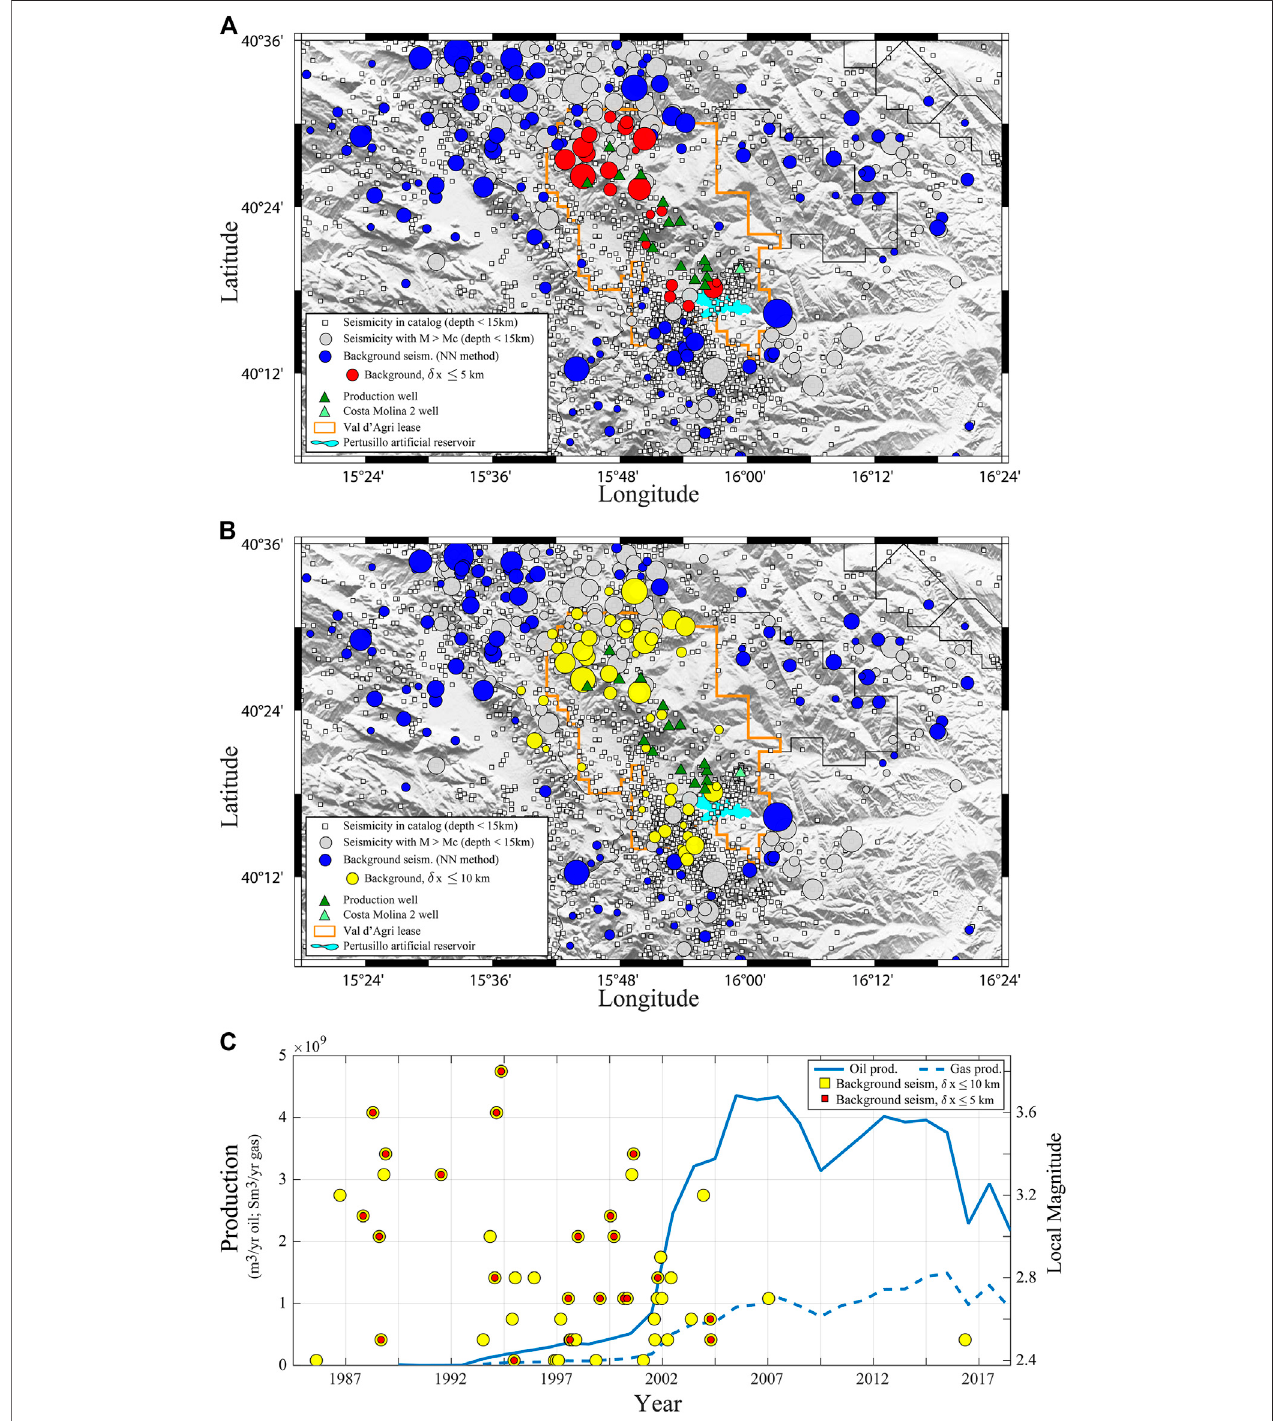
FIGURE9| SeismicandproductiondatausedintheanalysisfortheVald ’ Agrilease.Panels (A,B) showtheeventlocations:squaresrepresentthefullcatalog,and circles represent events above M c ; earthquakes identi fi ed as background seismicity are presented as colored circles, highlighting in particular the events located at distances δ x (cid:1) 5 (panel (A) , red circles) and 10 km (panel (B) , yellow circles) from the production wells. (C) Time series of production data and plot of the temporal occurrence and magnitude of seismic events